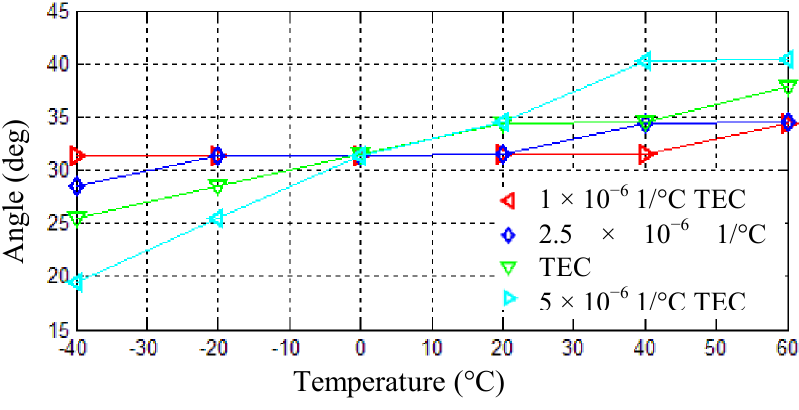
Figure 11. Position shifts of one antinode axis induced by thermal expansion